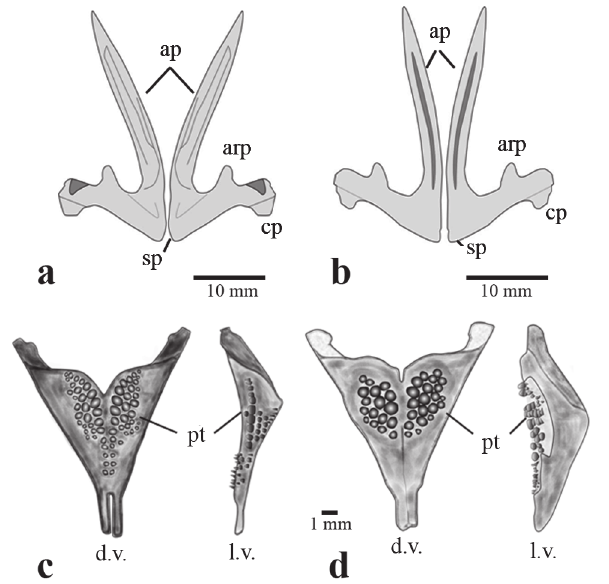
Fig. 7. Dorsal fin supports of ( a ) E. castroaguirrei ECOSC 5511-1, and ( b ) E. mexicanus UABC 2666. fds = first dorsal spine, sds = second dorsal spine, pr = proximal radial; anal fin supports of ( c ) E. castroaguirrei and ( d ) E. mexicanus. fas = first anal spine, sas = second anal spine, pr = proximal radial. Both structures from left